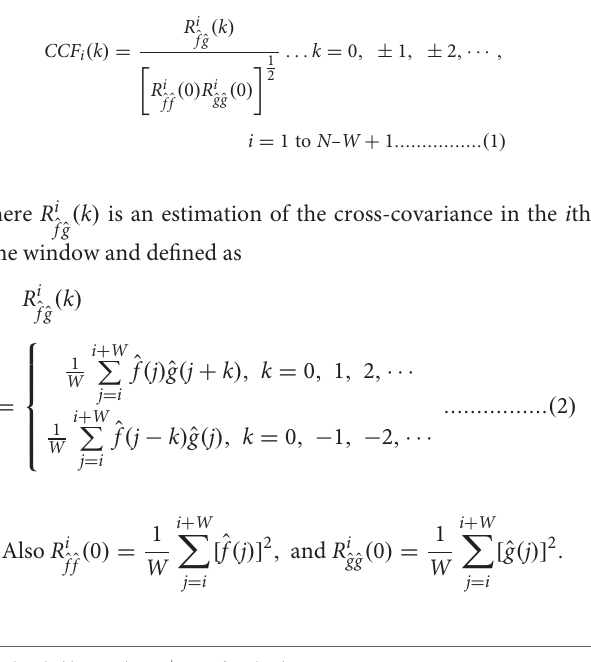
were bandpass filtered in low frequency (LF) ranges before applying the CCF. Where the LF range is 0.07–0.15 Hz, assume ˆ that bandpass filtered f(n) and g(n) signals are f ( n ) and ˆ g ( n ) , ˆ respectively. The CCF between f ( n ) and ˆ g ( n ) can be calculated